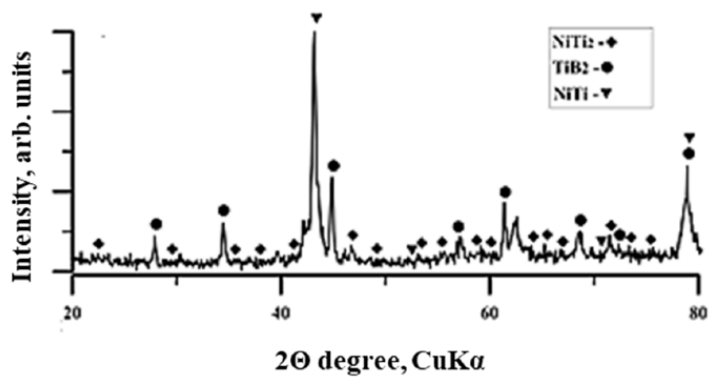
Figure 4. A typical X-ray diffraction pattern of the products of combustion of the Ti-NiB mixture.